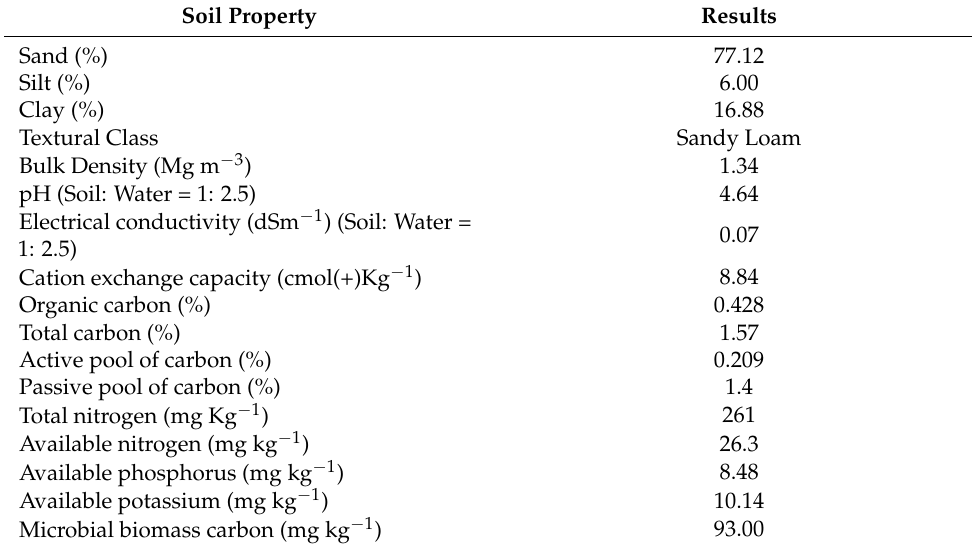
Table 1. Physical, chemical, and microbial properties of the lateritic soil from the field site in West Bengal,